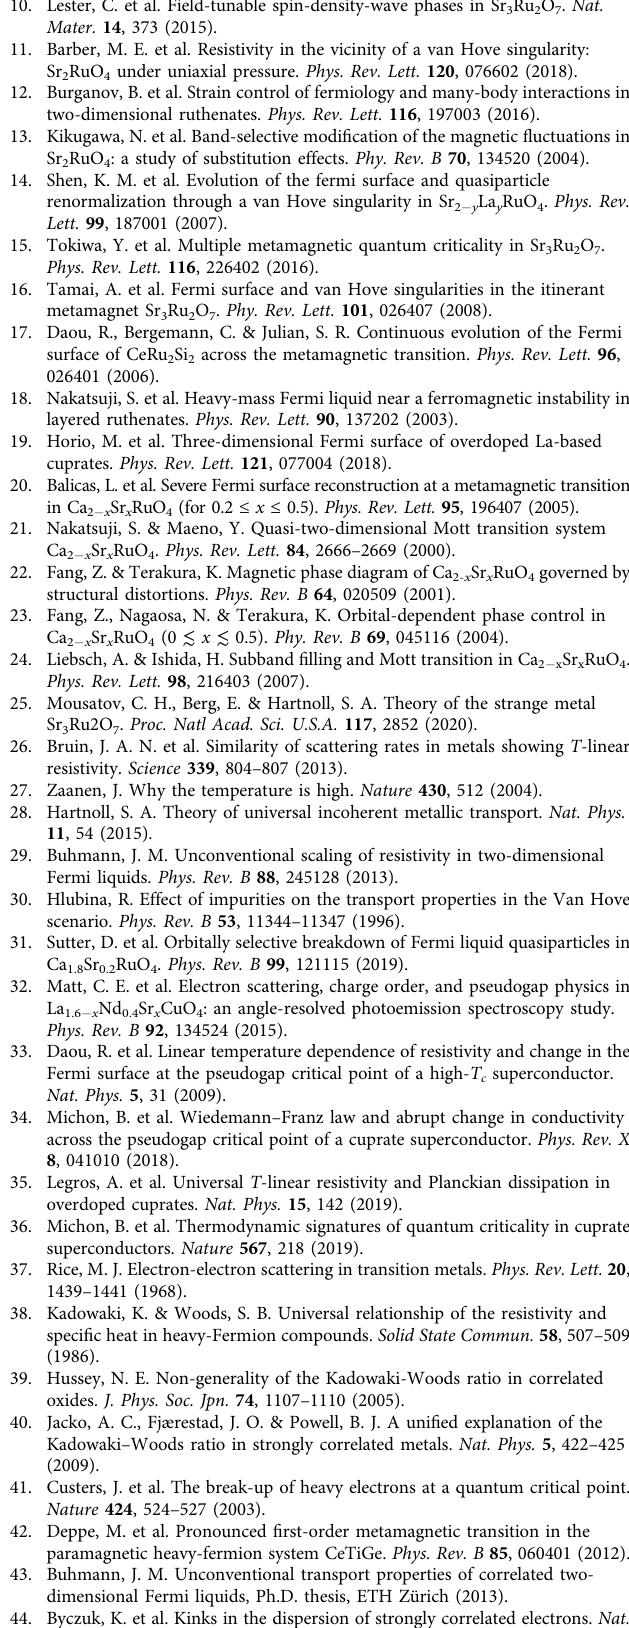
Methods Single crystals of Ca 1.8 Sr 0.2 RuO 4 were grown by the fl ux-feeding fl oating-zone technique 53,54 . Our experimental results were reproduced on several crystals that were cut and polished into a rectangular shape, with the largest natural plane being the ab plane. Magnetic fi elds μ 0 H ( μ 0 being the vacuum permeability) up to 9 T were applied along the c axis and silver paste electrical contacts were made on the ab plane. Resistivity measurements were performed in a physical property mea- surement system (PPMS, Quantum Design) with a Helium-3 option.